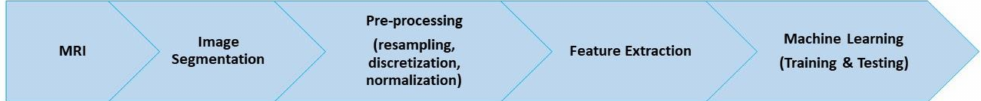
Figure 1. Workflow of the